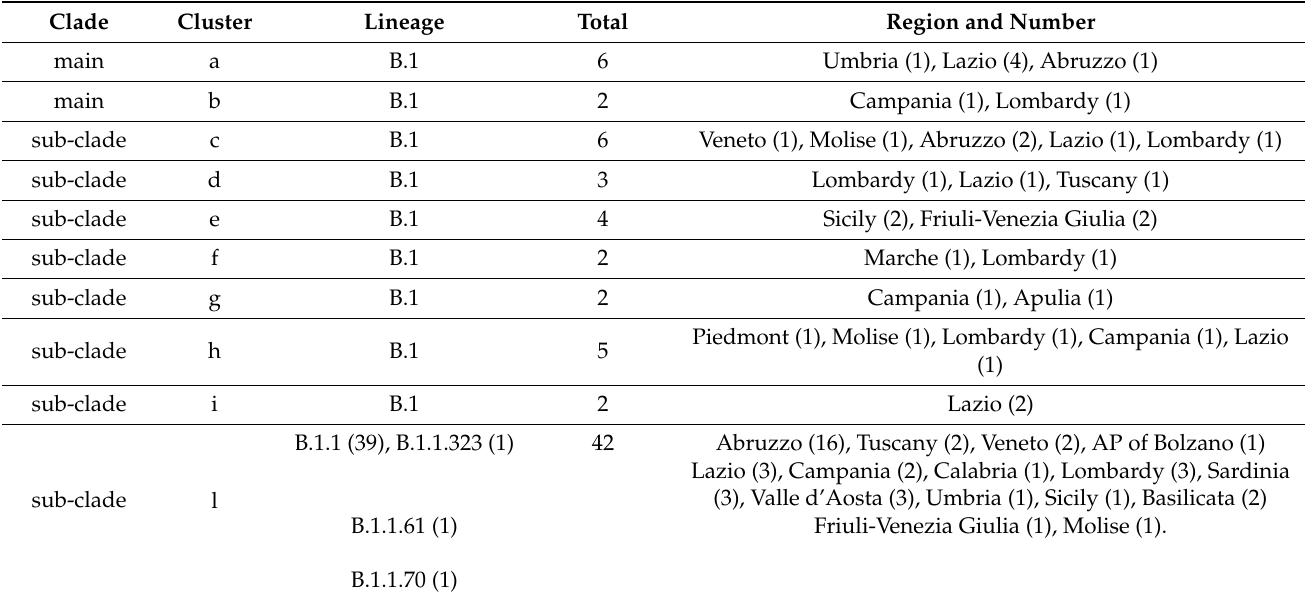
Table 1. Clades and clusters, lineage assignment, number of SARS-CoV-2 genomes, and re- gions/autonomous provinces referred to in the maximum likelihood tree reported in Figure